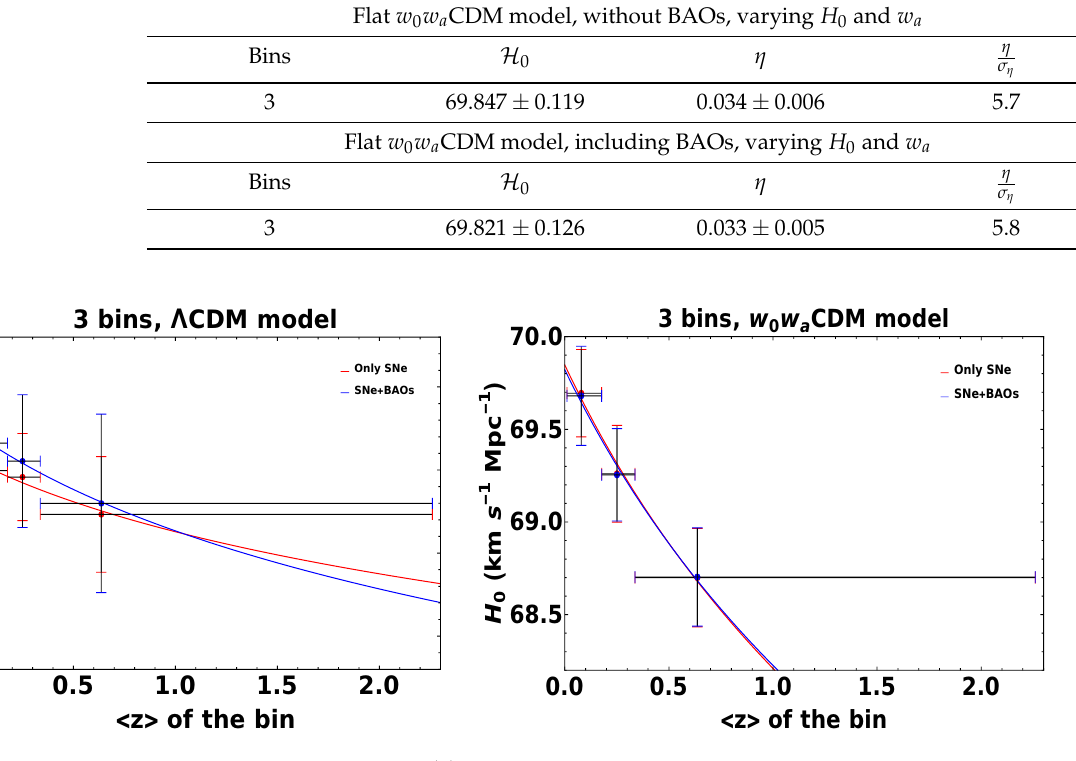
Figure 1. Left panel The H 0 ( z ) vs. z wit varying also Ω 0 M . The red color indicates the case with only SNe Ia as probes, while the blue refers to the case of SNe + 1 BAO per bin. This color-coded will be applied also in the right panel. Right. The same plot for the w 0 w a CDM model, considering the local fiducial value H 0 = 70, where both H 0 and w a are left free to